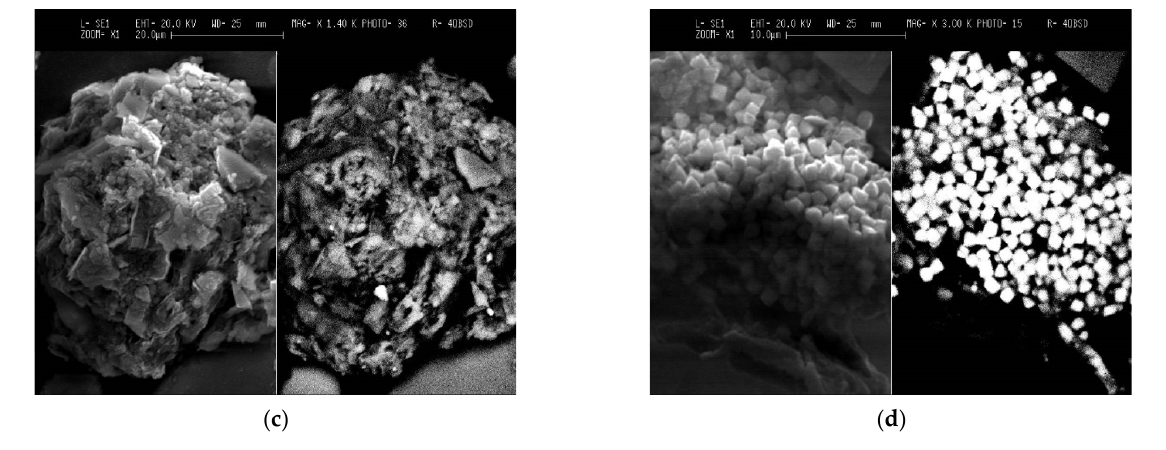
Figure 6. Phosphatic features investigated using SEM ‐ EDS analysis. ( a ) Phosphate bearing coatings and infillings on a sand grain (300 × SEM image taken in backscattered electron imaging); ( b ) Phosphate bearing coatings on a vegetal remain (24 × SEM taken in secondary imaging); ( c ) Phosphate bearing impregnations on a crumby microaggregate (1400 × SEM image taken in secondary image on the left and backscattered electron imaging on the right); ( d ) Organo ‐ minerals associations (3000× SEM image taken in secondary image on the left and backscattered electron imaging on the right).